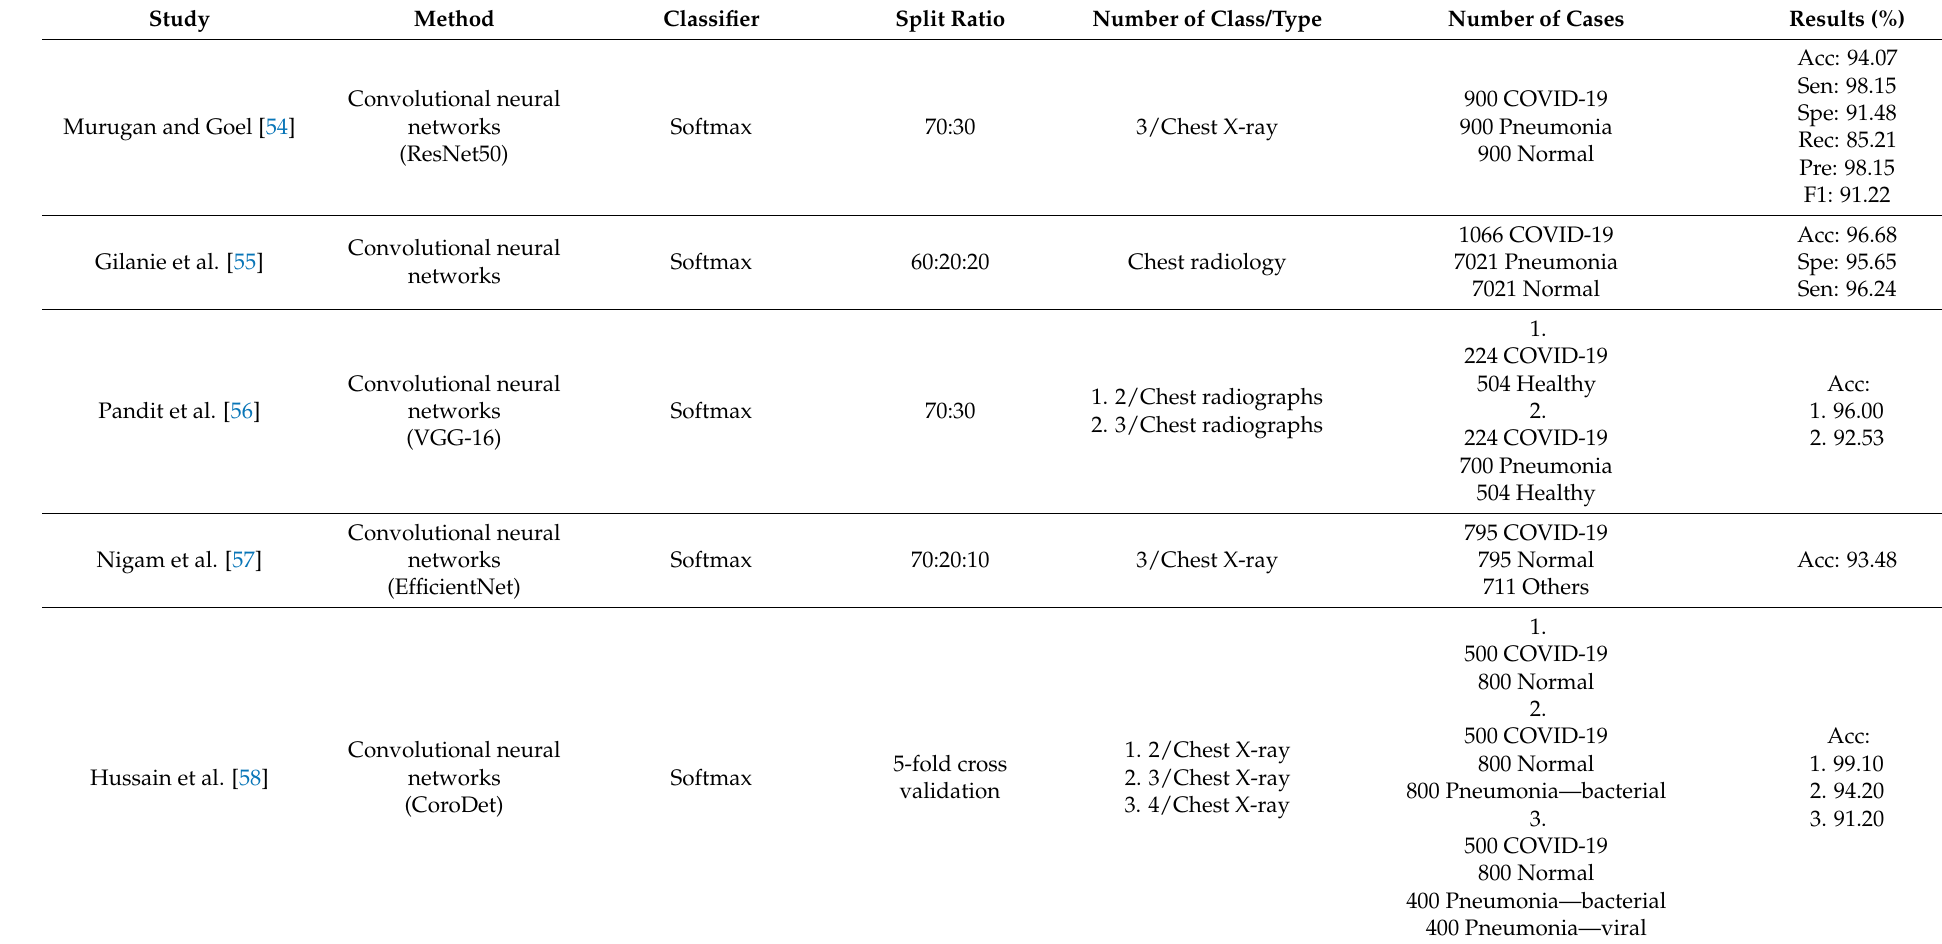
Table 9. Comparison of our work with other similar published